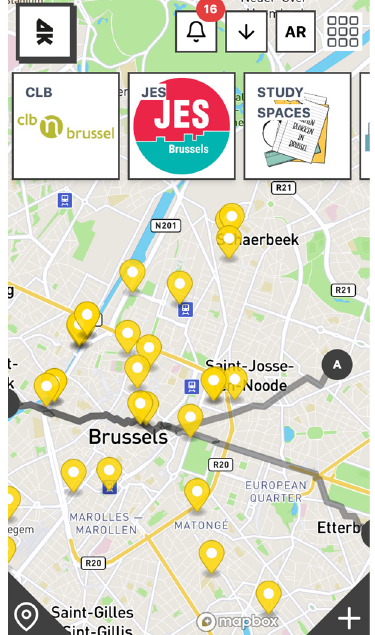
Figure 2. Map view of the Card Interface.